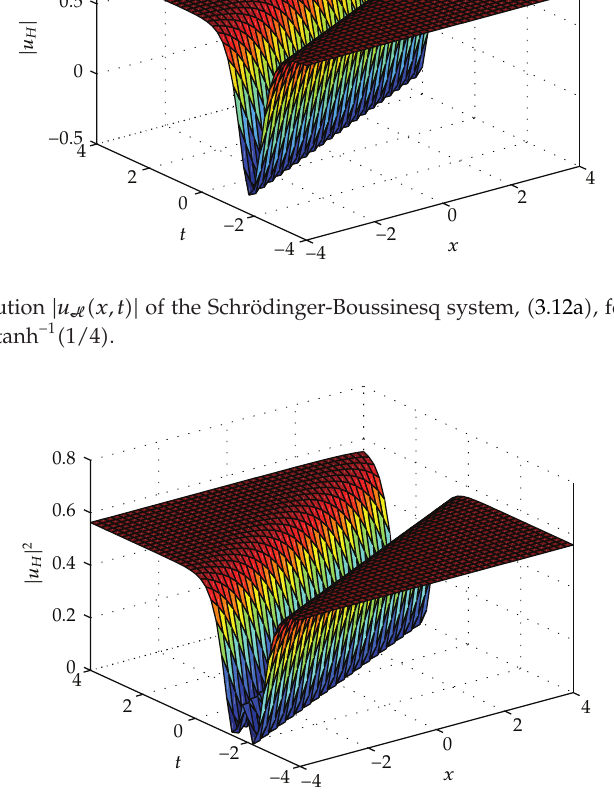
Figure 2: Soliton solution | u H (cid:4) x,t (cid:5) | 2 of the Schr¨odinger-Boussinesq system, (cid:4) 3.12a (cid:5) , for α (cid:3) 1 , β (cid:3) 16 , k (cid:3) 1 , ω (cid:3) − 2, and ρ H (cid:3) tanh − 1 (cid:4) 1 / 4 (cid:5)